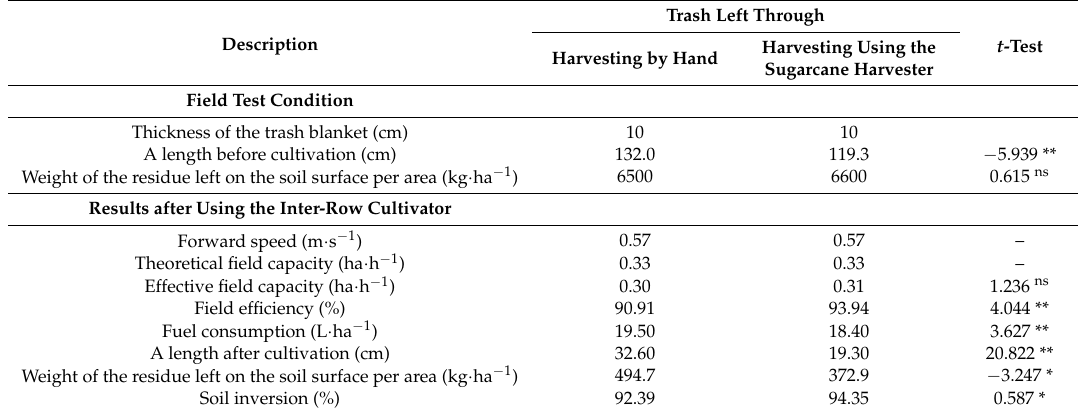
Table 2. The performance test and the practical field test of an inter-row cultivator attached to a 25.3-kW